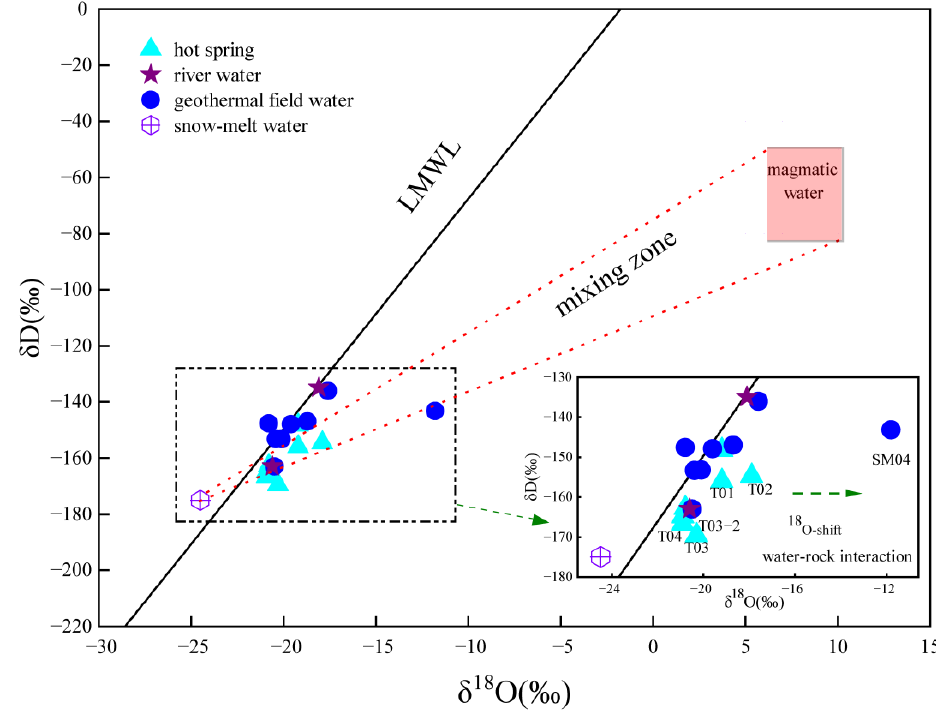
Figure 2. δD–δ 18 O plot from the hot springs, geothermal field waters, river waters, and snow-melting water in South Tibet. The LMWL (δD = 8.0 × δ 18 O + 14.4) and magmatic fluid distribution (δ 18 O = 7 ± 2‰, δD = −25 ± 10‰) are from Tan et al. [27]. The phenomenon in which the contents of δD and δ 18 O decrease with the height in- crease in atmospheric precipitation is called the isotope elevation effect. This effect can be applied to estimate the recharge elevation of water samples [33]. The recharge elevation formula of the δD value in precipitation and local altitude is H = h+(R -R*)/K, where h is sampling point elevation; R is the δD value from the sampling water; K is height gradient